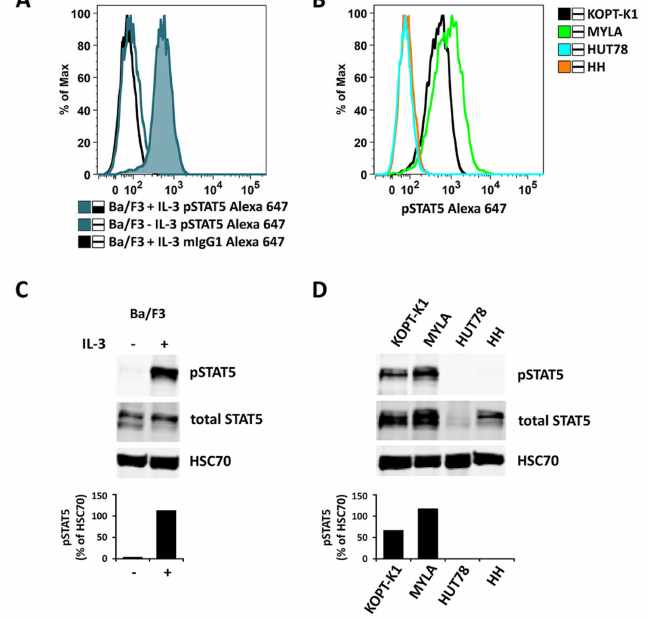
Figure A5. Ba / F3 cells were kept in medium without IL-3 overnight and split in the morning. One half was incubated with 10 ng / mL IL-3 for 40 min (Ba / F3 + IL-3), while the other half was kept in medium without IL-3 (Ba / F3 − IL-3). Thereafter, cells were analyzed for expression of pSTAT5 either by flow cytometry ( A ) or Western blotting ( C ). In ( A ), an Alexa-647-labeled anti-pSTAT5 antibody was used (with IL-3: blue histogram; without IL-3: open blue histogram). mIgG1 Alexa-647 was used as an isotype control (open black histogram) in Ba / F3 + IL-3 cells ( A ). Human lymphoma cell lines with detectable pSTAT5 levels (KOPT-K1 and MYLA) or no detectable pSTAT5 (HUT78 and HH) were also analyzed for pSTAT5 expression using flow cytometry ( B ) and Western blotting ( D ). In Western blot experiments, HSC70 served as a loading control. The columns show the levels of pSTAT5 in percent of HSC70 as analyzed by densitometry. Uncropped blots are shown in Figure